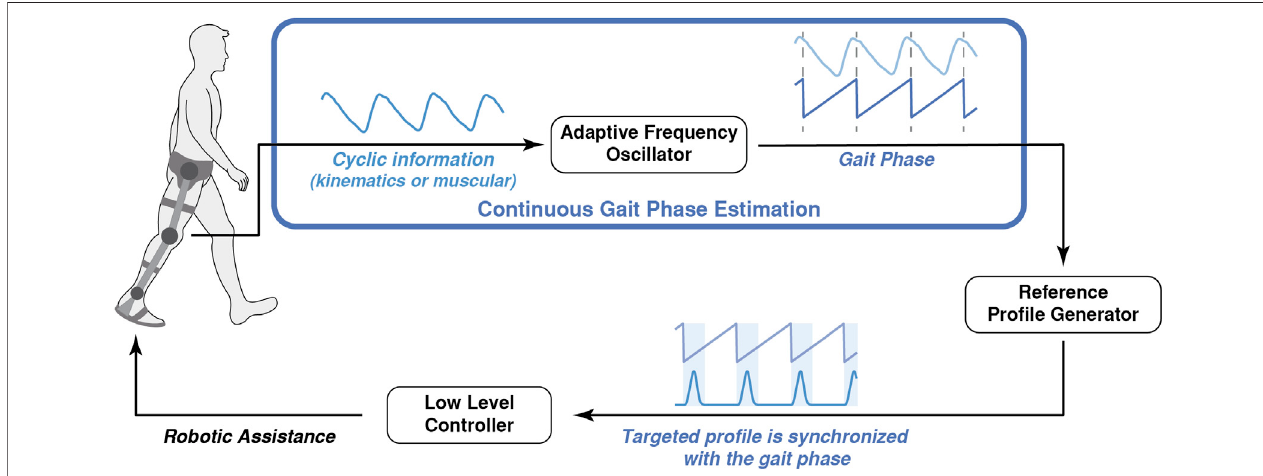
FIGURE4| Conceptual representation oftherobot-gaitcoordination based onthe gait phase estimationperformed byanAdaptiveFrequency Oscillator: theAFO estimates the continuous gait phase and uses it to synchronize the application of an assistive pro fi le.